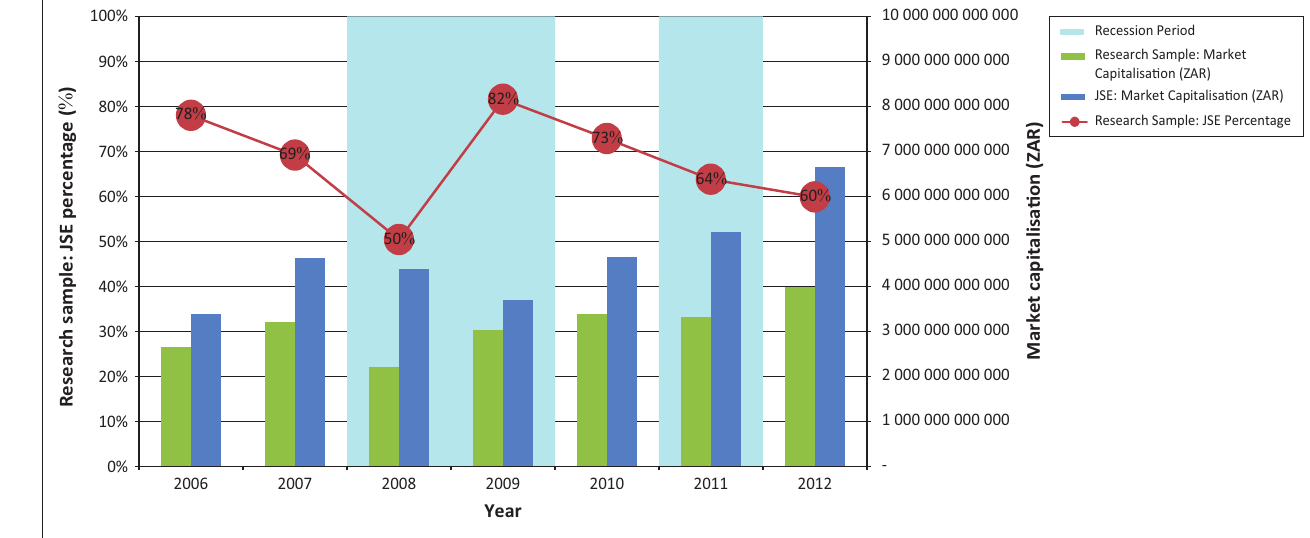
FIGURE 3: Market capitalisation: Research sample versus JSE. TABLE 4: Organisational performance measures means. Year Market capitalisation (ZAR)